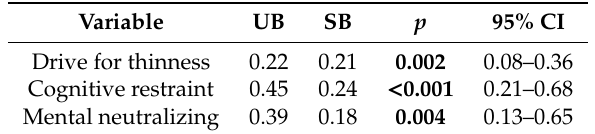
Table 9. Multivariable analysis: Forward linear regression taking the DOS total score as the dependent